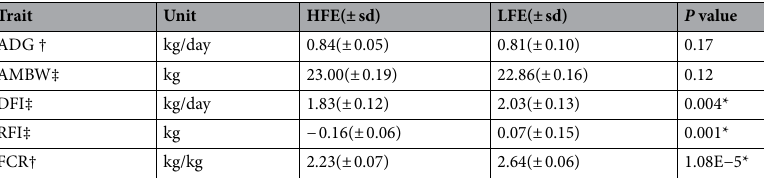
Table 1. Descriptive statistics of high feed efficiency (HFE) and low feed efficiency (LFE) for phenotypic traits. ADG average daily gain, AMBW average metabolic body weight gain, DFI daily feed intake, RFI residual feed